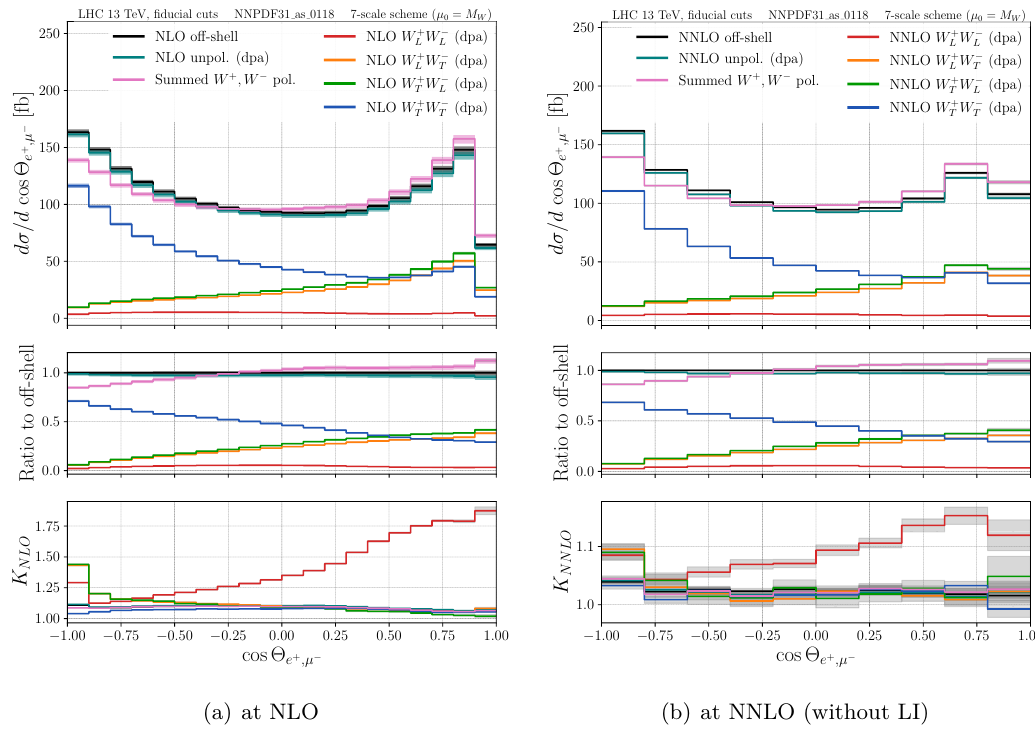
Figure 3 . Distribution of cosine of angle between charged leptons. Doubly-polarised setups are shown. Individual plot substructure is the same as in figure